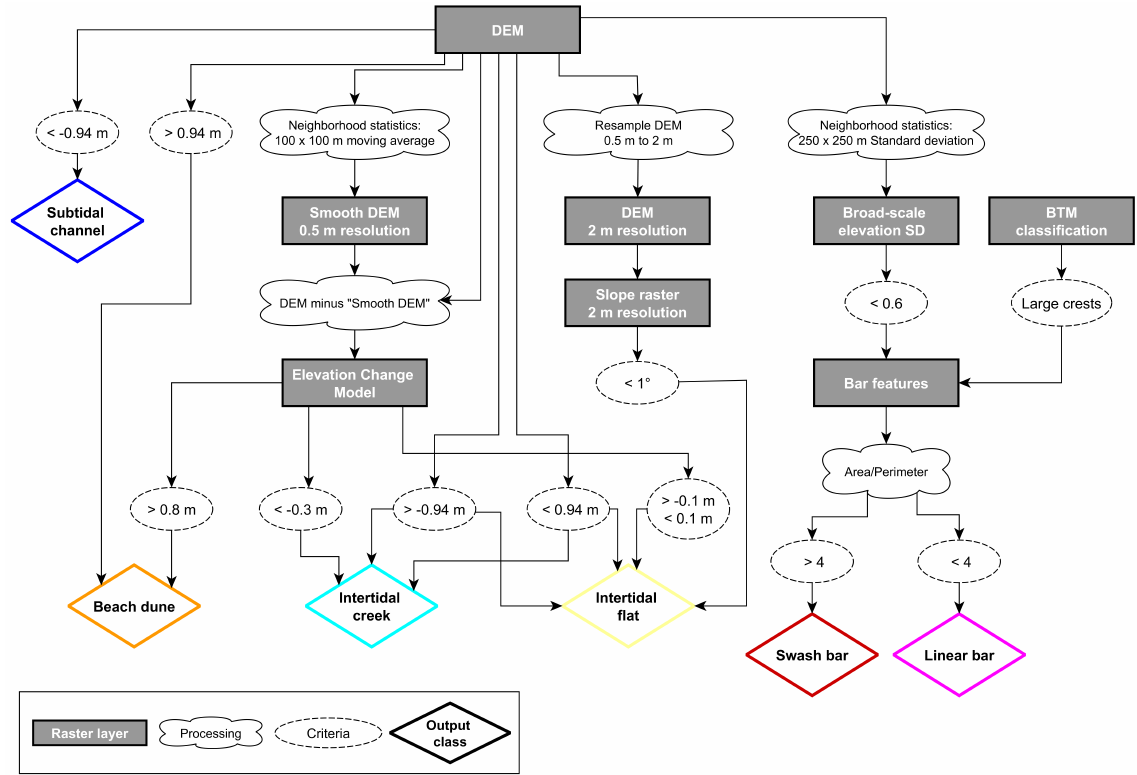
Figure 5. Classification decision tree of the morphological classification. All steps were performed in